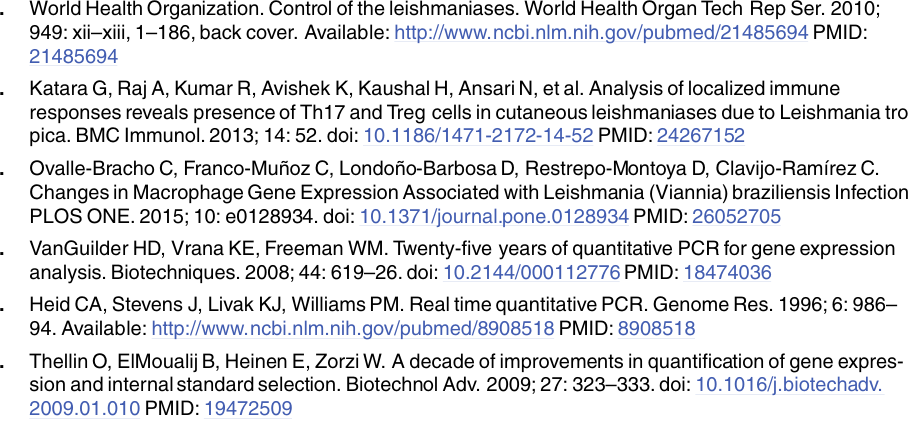
S2 Table. Stability values of all 71 candidate reference genes for spleen samples of control BALB/c mice, ranked by geNorm, NormFinder and RefFinder. S3 Table. Stability values of all 71 candidate reference genes for spleen samples of Leish- mania -infectedBALB/c mice, ranked by geNorm, NormFinder and RefFinder. S4 Table. Stability values of all 71 candidate reference genes for spleen samples of control and Leishmania -infected BALB/c mice, ranked by geNorm, NormFinder and